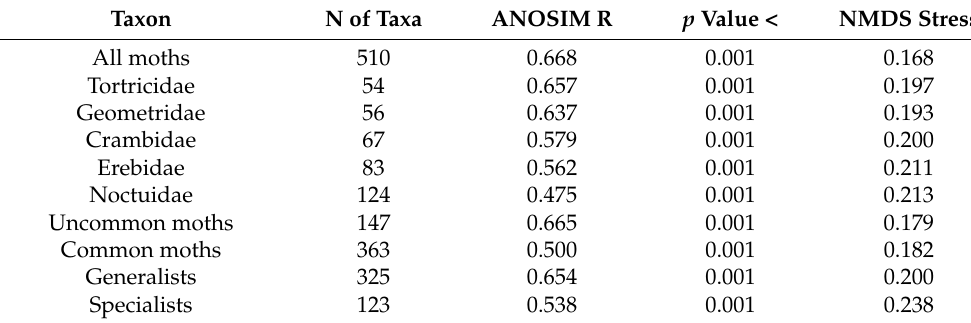
Table 1. Statistical values for nMDS and ANOSIM